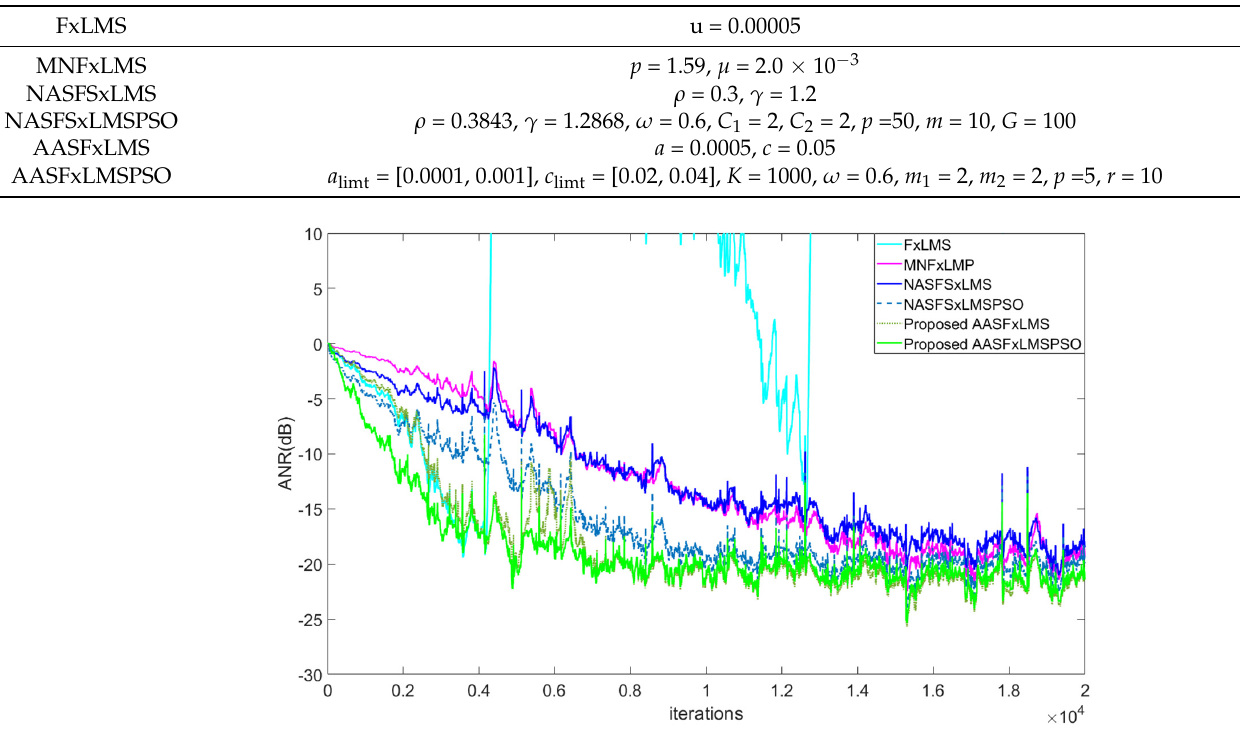
Figure 9. The noise reduction effect of the S α S distributed pulse noise, where α = 1.3.